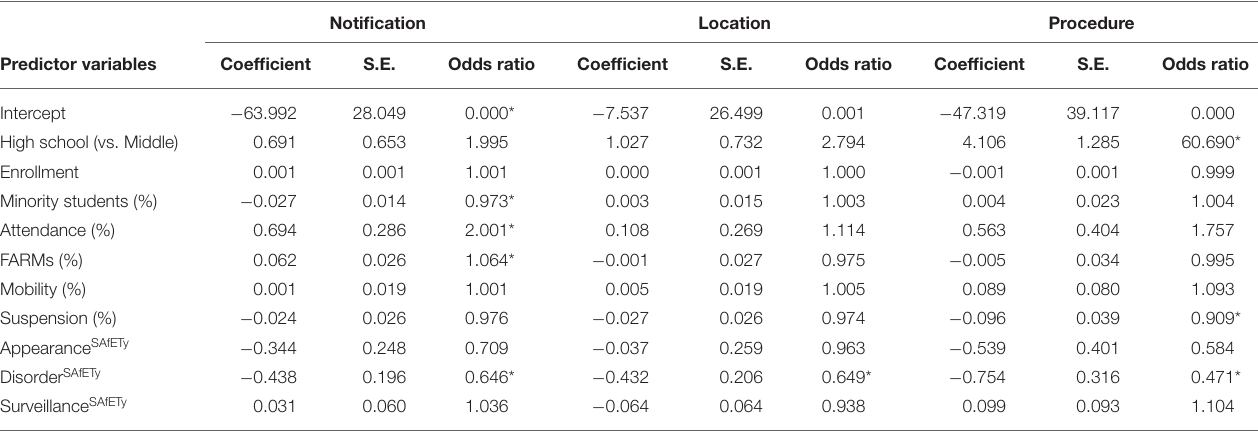
TABLE 2 | Logistic regression analyses for school-level demographics and the mean SAfETy scores for the three crisis